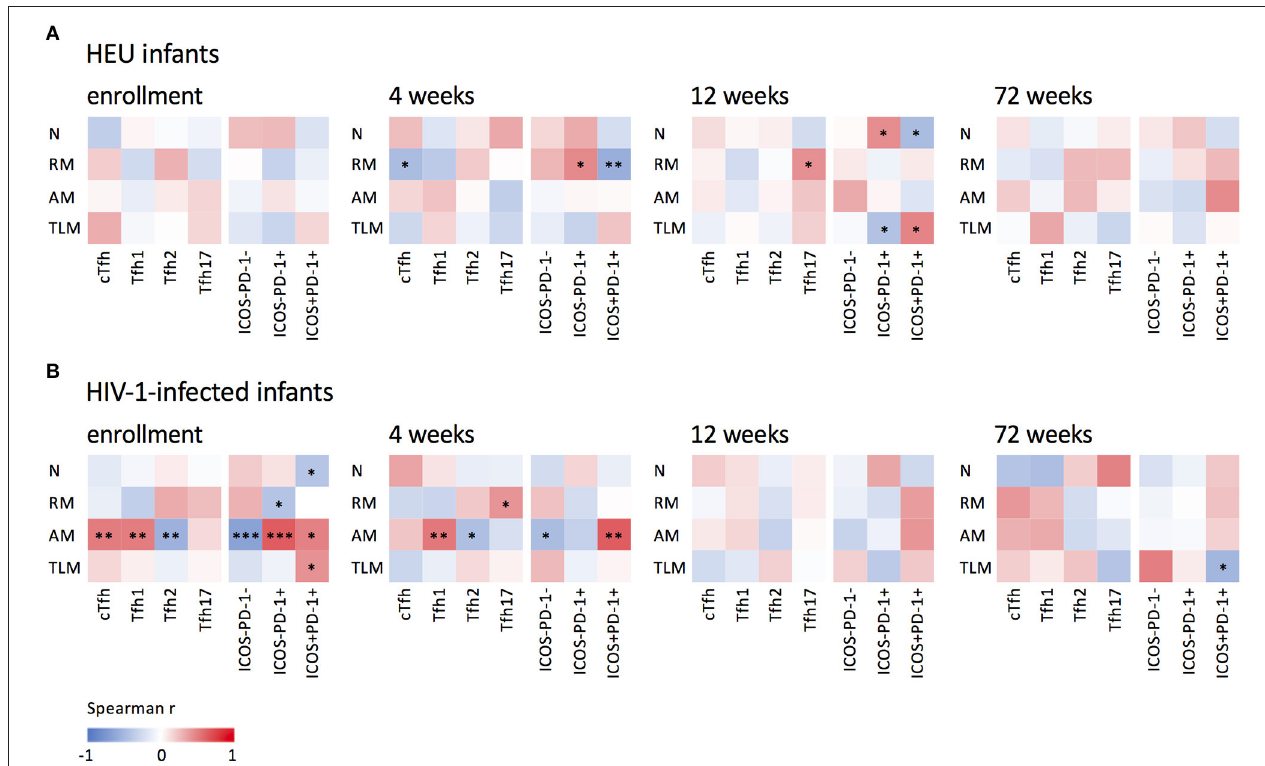
FIGURE 5 | Associations between B and cTfh cells. Correlations between naïve (N), resting memory (RM), activated memory (AM), and tissue-like (TLM) memory B cells and cTfh, Tfh1, Tfh2 and Tfh17 subsets and quiescent (ICOS-PD-1- and ICOS-PD-1 + ) and activated (ICOS + PD-1 + ) Tfh cells in (A) HEU infants and (B) HIV-1-infected and at enrollment, 4, 12, and 72 weeks. *** P < 0.001, ** P < 0.01, * P <